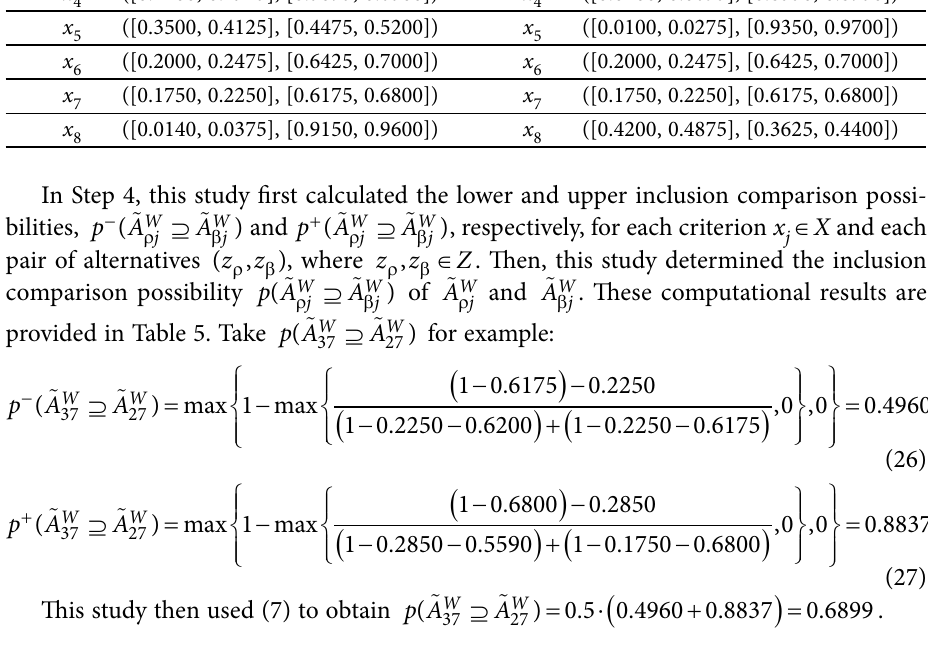
Table 5. Results for the inclusion comparison